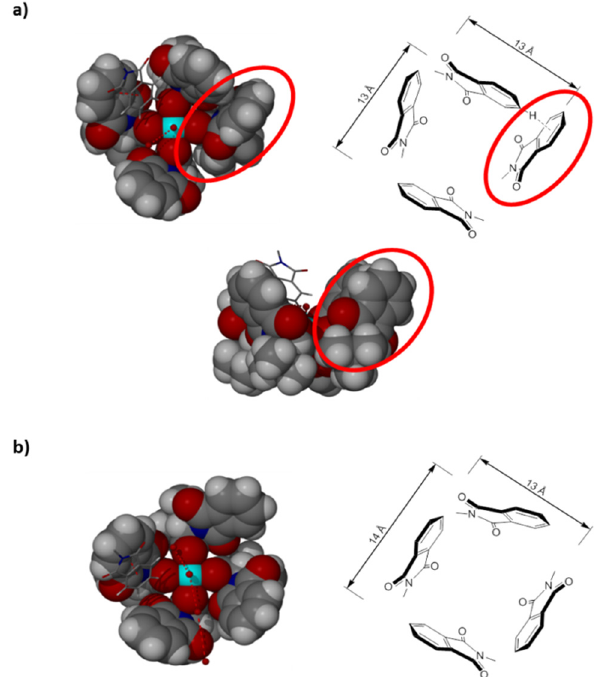
Figure 3. Space filling and schematic representations of the irregularly shaped chiral crown cavities of; ( a ) [Rh 2 ( S -PTTL) 4 .(H 2 O)] and ( b ) [Rh 2 ( S -PTTL) 4 .2(H 2 O)]. Rh bound and lattice water molecules are depicted in stick form (hydrogen atoms of all water molecules could not be located and the extended hydrogen bonded structure is not shown beyond the asymmetric unit). Also shown in stick form are the endo -cavity residing N -phthaloyl units of the adjacent crystallographically distinct complex featuring face-to-face π -stacking interactions. A side view into the equatorial plane of the Rh centers is given in ( a ) to highlight the significantly different conformation of one of the ligands that results in “reversal” of the chirality of the crown